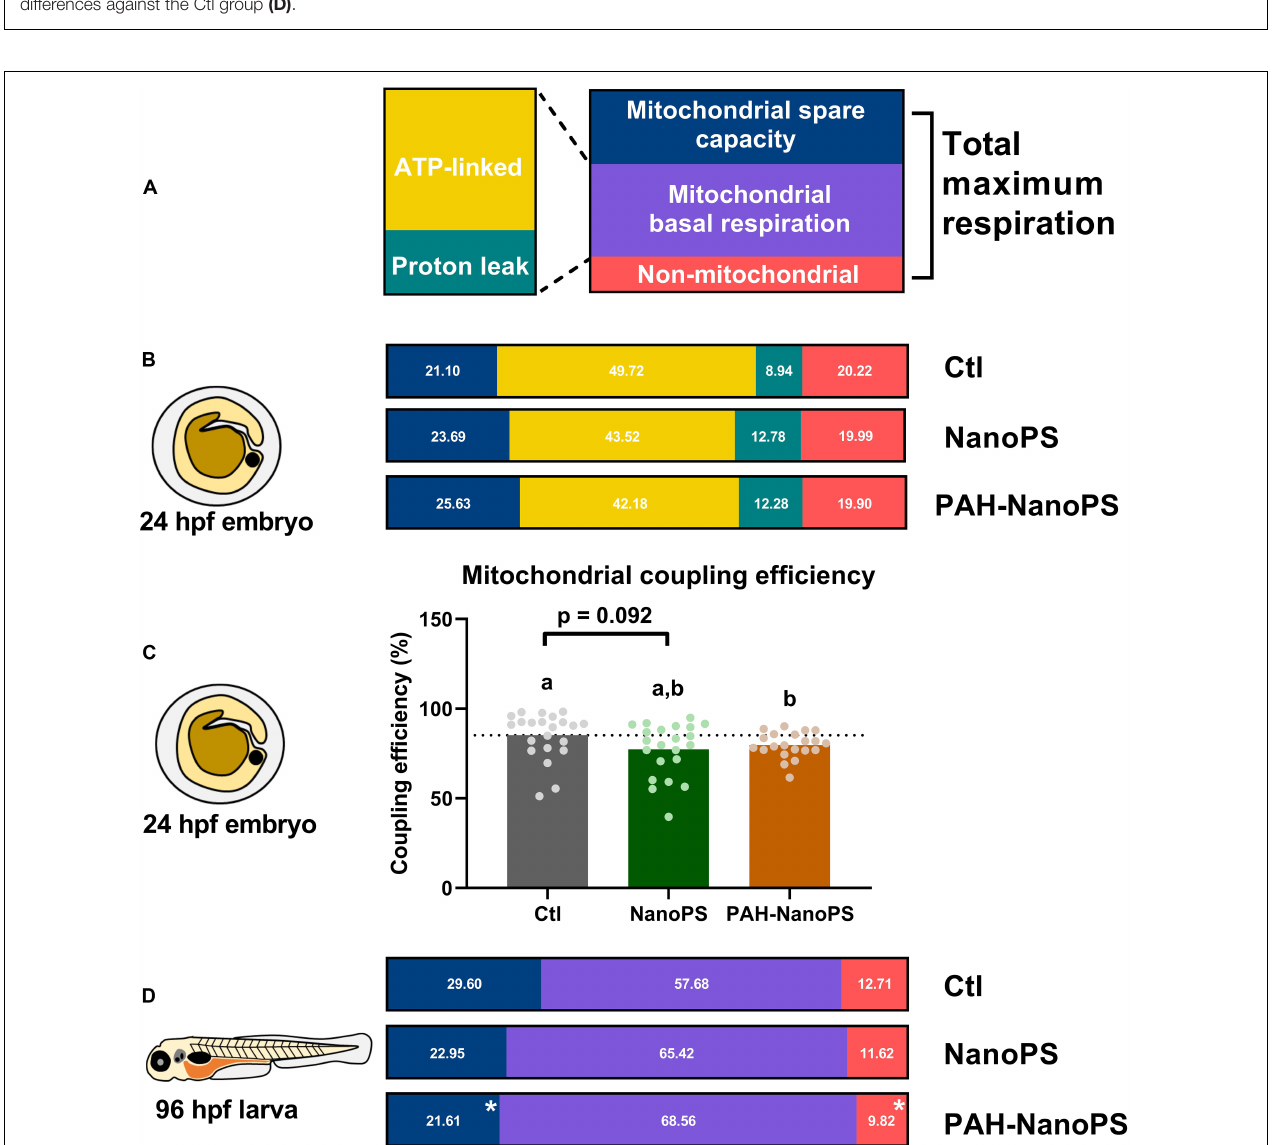
FIGURE 5 | Mitochondrial bioenergetics profiles of zebrafish embryos and larvae. Animals were exposed at 6 h post-fertilization (hpf) to 1 ppm polystyrene nanoparticles (NanoPS) or 1 ppm polystyrene nanoparticles with PAHs sorbed to their surface (PAH-NanoPS) (please see Figure 1 and section “Sorption of PAHs to the surface of NanoPS” for further details). (A) In vivo oxygen consumption rates (OCR) in 24 hpf embryos, shown as the proportion of OCR due to the mitochondrial spare capacity, ATP synthase (ATP-linked), proton leak, and non-mitochondrial respiration. The percentages were calculated based on the in vivo total maximal OCR values (100%, sum of non-mitochondrial, mitochondrial basal and spare capacity). (B) Mitochondrial coupling efficiency of oxidative phosphorylation in 24 hpf zebrafish embryos, shown as average and the scatter plot of individual replicates ( n = 21–22). The dotted line represents the average of the control group. (C) In vivo oxygen consumption rates (OCR) in 96 hpf larvae, shown as the proportion of OCR due to mitochondrial spare capacity, basal mitochondrial respiration (sum of ATP-linked and proton leak), and non-mitochondrial respiration. ATP-linked respiration, proton leak respiration, and mitochondrial coupling efficiency could not be determined in larvae due to their lack of response to the chemical drugs used in the assay. (D) Metabolic partitioning of whole animal OCR used in the present study. For the bioenergetics partitioning, * represents statistical difference when compared to the control group ( p < 0.05), while for the mitochondrial coupling efficiency groups not sharing letters indicate statistical differences ( p < 0.05). Please see Supplementary Material for additional information on the assay, equations for the bioenergetics partitioning, and additional statistical analyses.